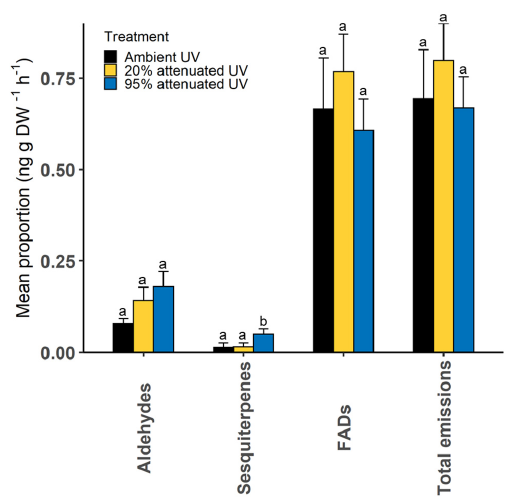
Figure 1. Proportions of major chemical classes in heather plants exposed to ambient and attenuated UV (n = 10 for each treatment). Y-axis shows log10x + 1 transformed mean ± SE proportion of compound classes. Different letters indicate significant differences.